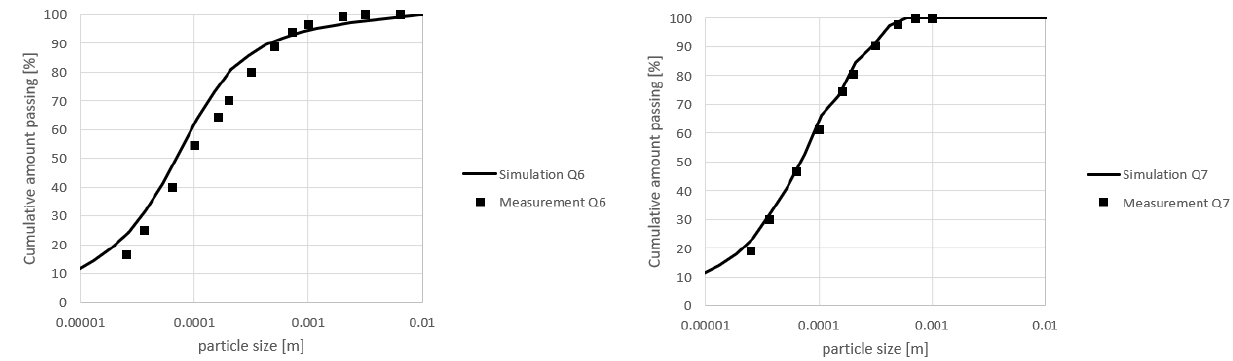
Figure 3. A comparison of psd data for the product from the mill and the